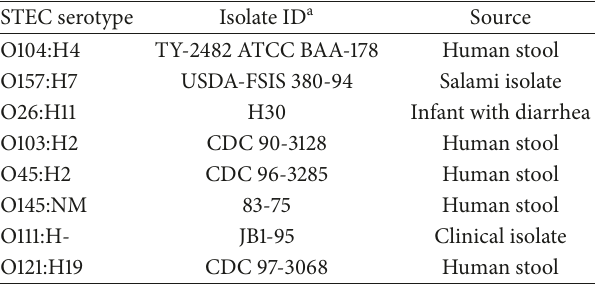
Table 1: Shiga-toxigenic Escherichia coli isolate identification and